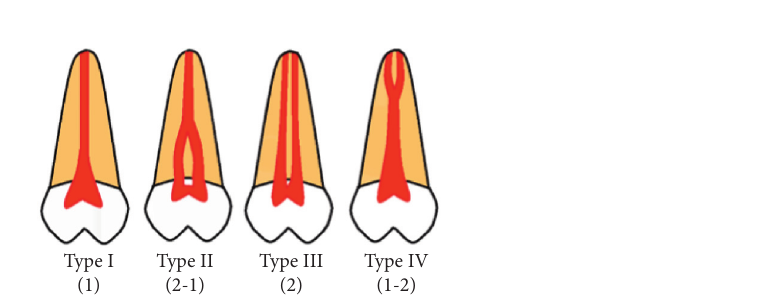
Figure 1: Illustrative image of the morphological classification of root canals according to Weine et al. [14].